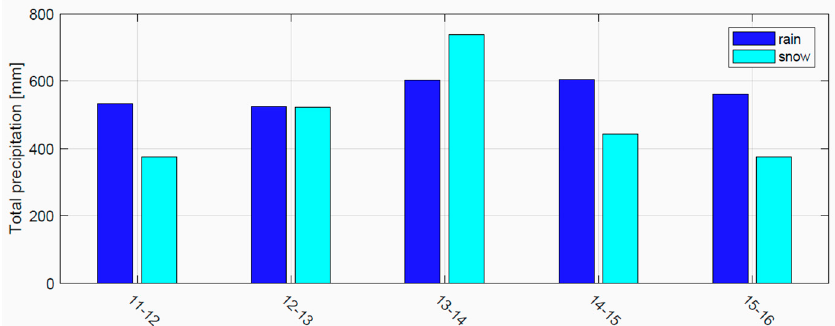
Figure 2: Mean areal snowfall and rainfall, cumulated over each hydrological year (01 October to 30 September) for the considered study period (2011 −